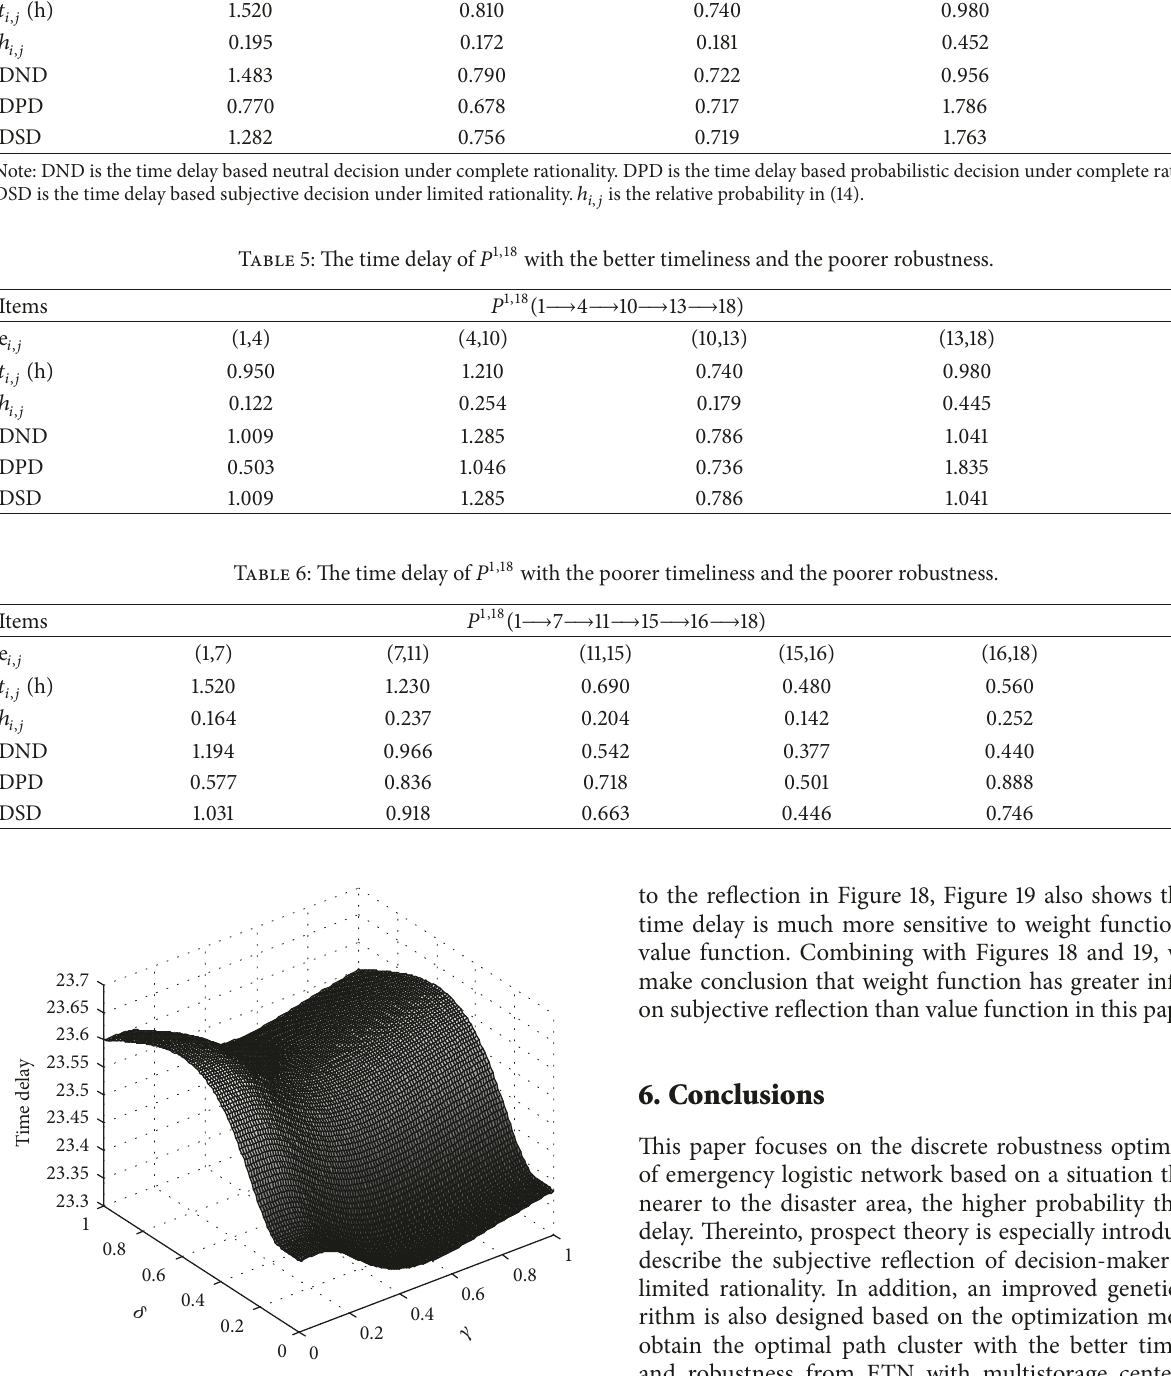
As shown in Figure 19, the influence on time delay caused by variation of 𝛽 is obvious when 𝛿 ≥ 0.4 , and the influence caused by 𝛿 is obvious when 𝛽 ≤ 0.7 .